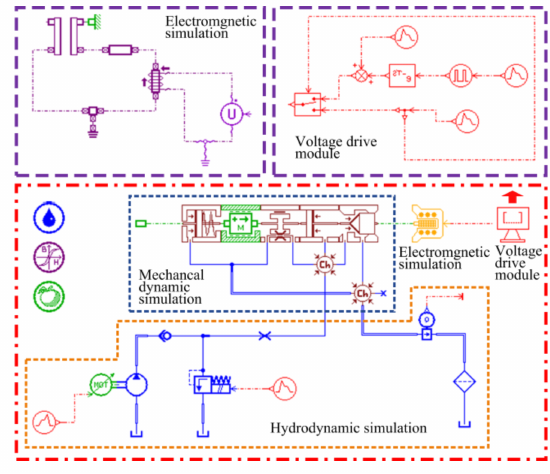
Figure 4. The SCV simulation model.